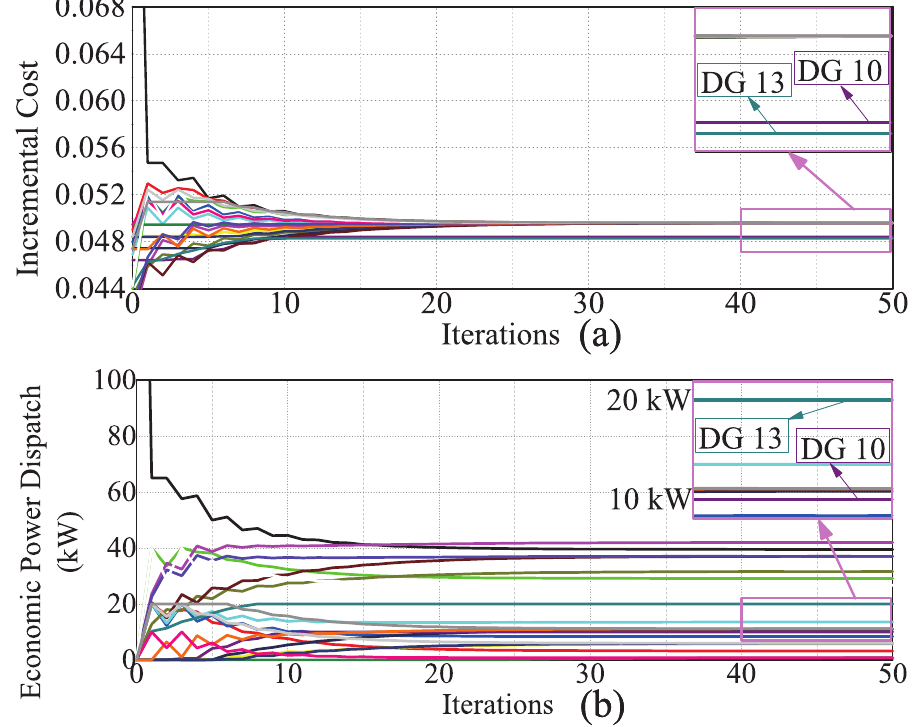
Figure 8. Convergence test of the EPD and ABVO algorithms for a larger DC microgrid with 20 DGs when two DGs reached their rated power. ( a ) Incremental cost of the DGs in each iteration; ( b ) EPD of the DGs in each